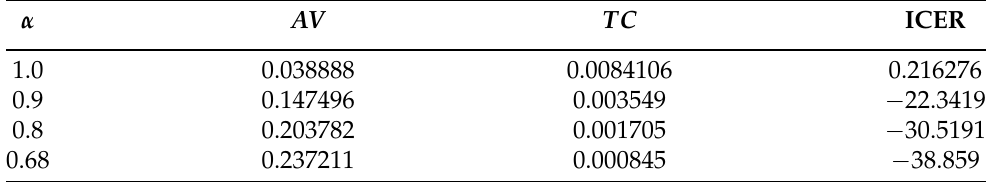
Table 6. Incremental cost-effectiveness ratio for strategy B and several derivative orders. Same conditions as Table